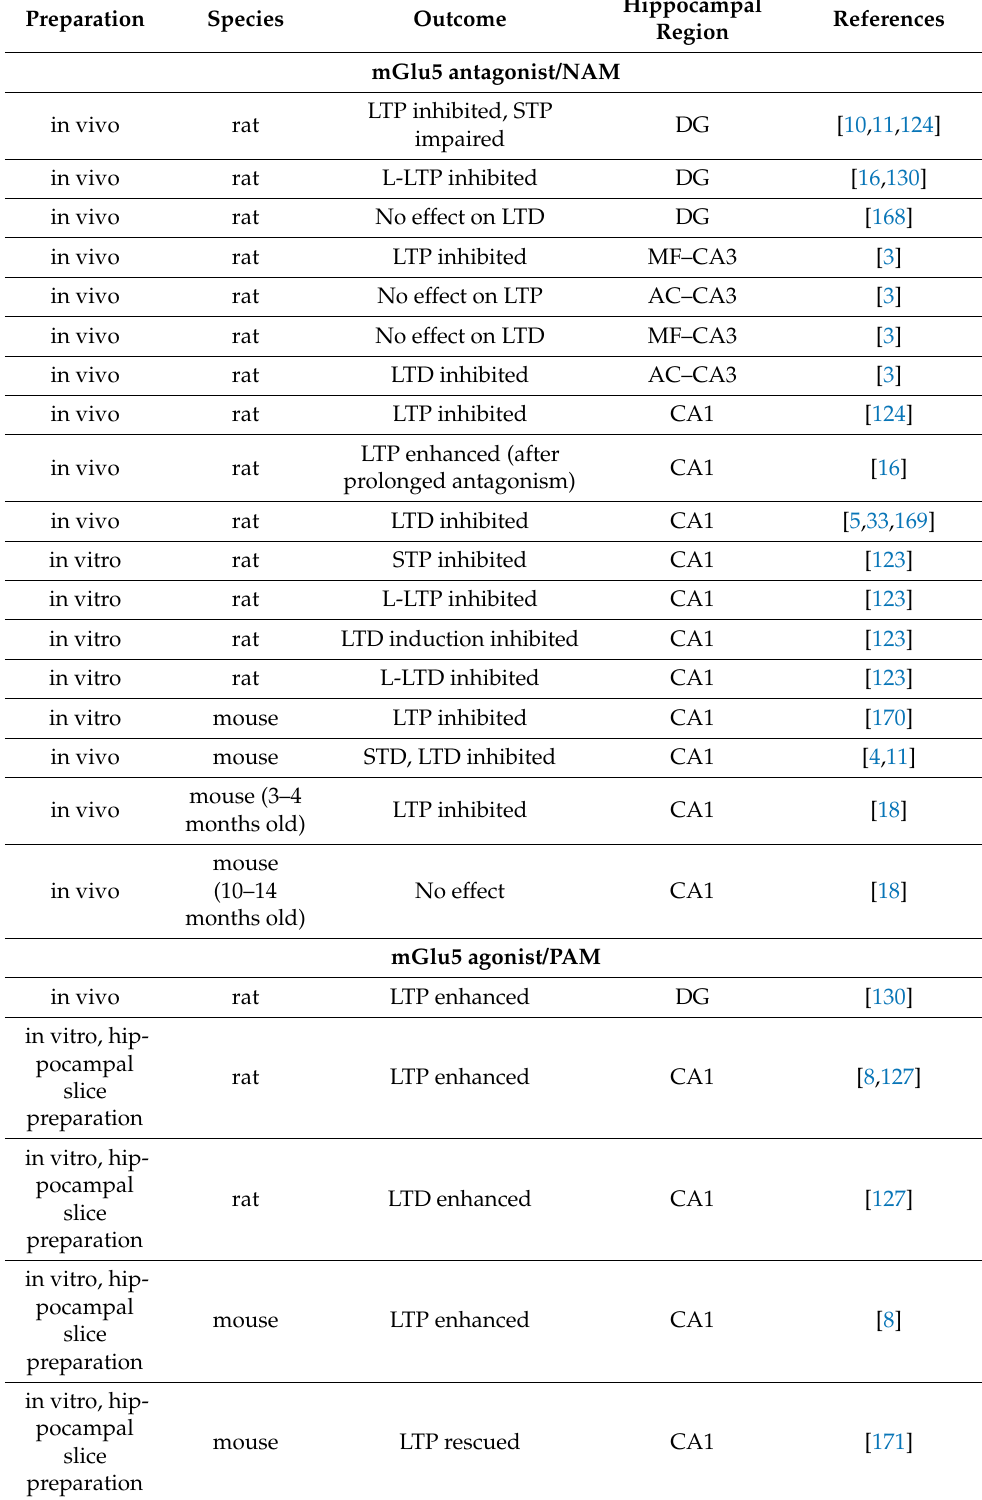
Table 1. Summary of mGlu5 receptor contribution to short-term potentiation (STP), long-term potentiation (LTP), short-term depression (STD) and long-term depression (LTD) in the hippocampal perforant path–dentate gyrus (DG), mossy fiber–CA3 (MF-CA3),